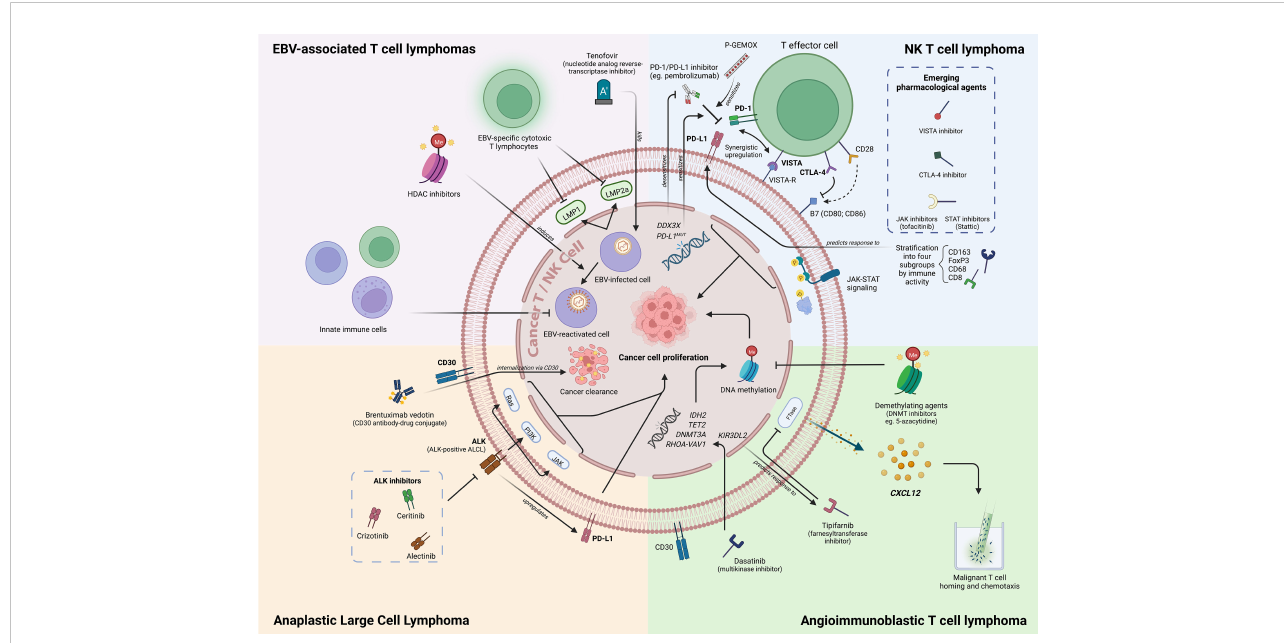
FIGURE 1 An overview of novel biomarkers in PTCL/NKTCL. Figure created with